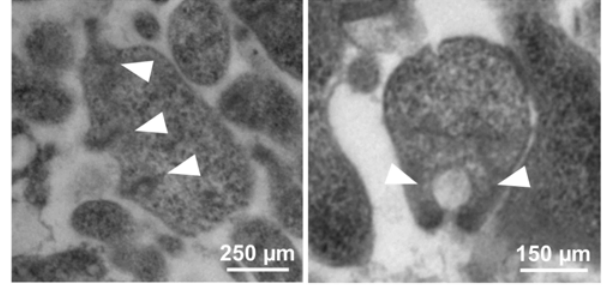
Figure 5. Transmission electron microscopy analysis of the T192 mutant. Arrowheads highlight the presence of several electron- dense cores inside a single cell.